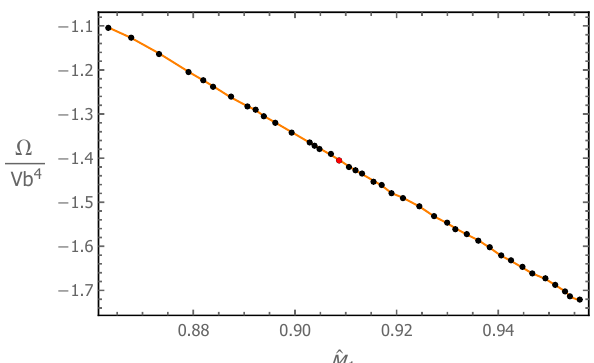
Figure 9. The free energy density as a function of M 1 /b = M 2 /c at c/b = 1 across the critical point. The red dot is the value of free energy density at the critical red dot in figure 6. We found the phase transition is continuous and smooth (up to our numerical